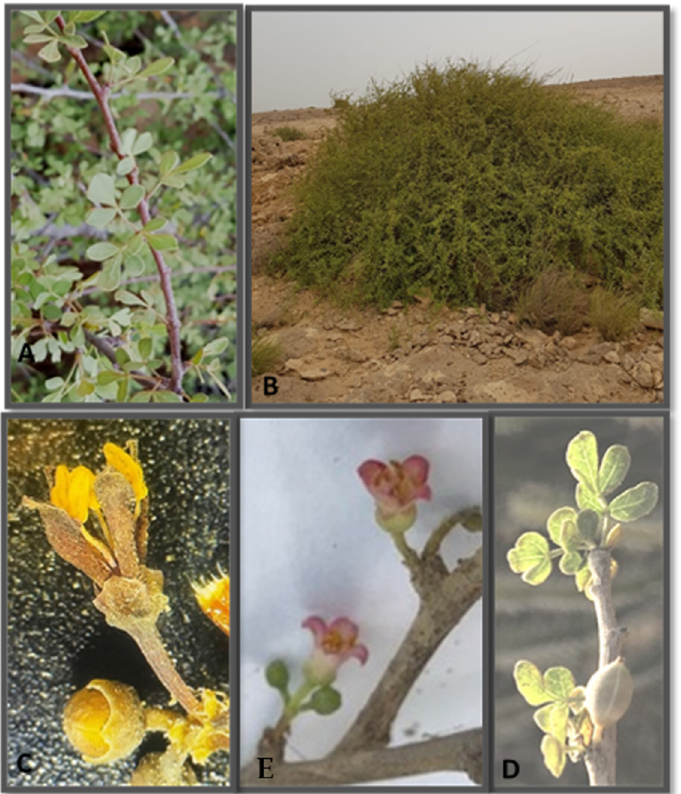
Figure 4. Commiphora erythraea ; ( A ): whole plant at naked stage, leaves at upper corner; ( B ): flowers upper view, and one flower is magnified at 1.2 X; ( C ): fruits with dried twigs.